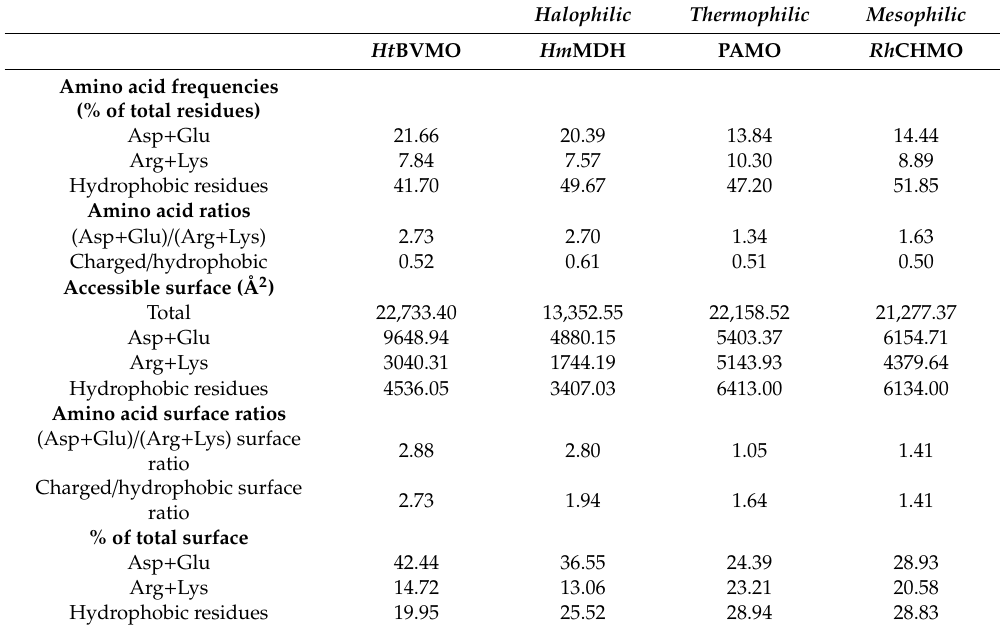
Table 1. Comparison of amino acid surface